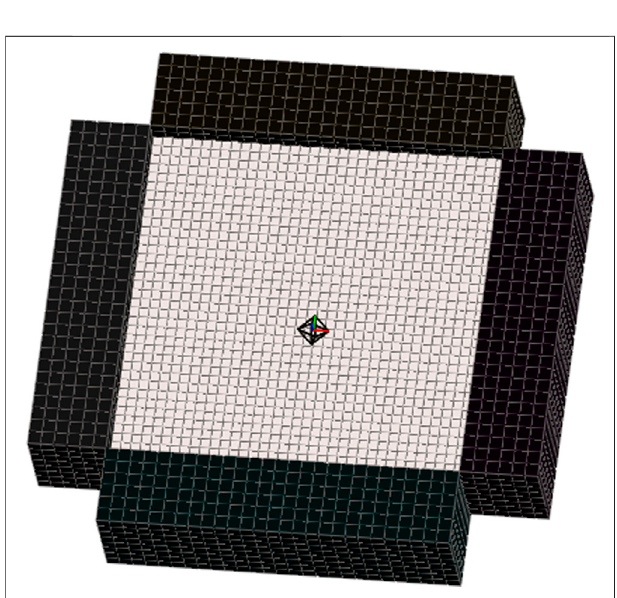
FIGURE 2 | Finite element model was used to simulate biaxial testing of the porcine aorta wall tissue specimens reported by Polzer et al. Specimen dimensions matched those given by Polzer and displacements of rigid test grips were set to match the stretch ratios and loading rate. Cauchy stress versus stretch wascalculated for all J750 constitutive models using the model. Model of aorta wall specimen contained 5,184 8-node hexahedral elements and 6,845 nodes. Sliding elastic tension contact was assumed between rigid grips and